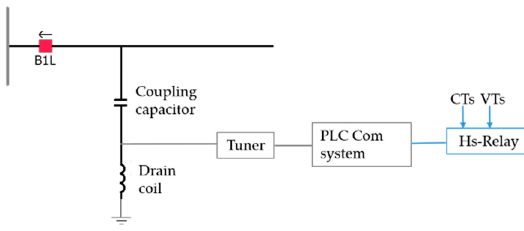
Figure 2. Proposed half-sine injection system.